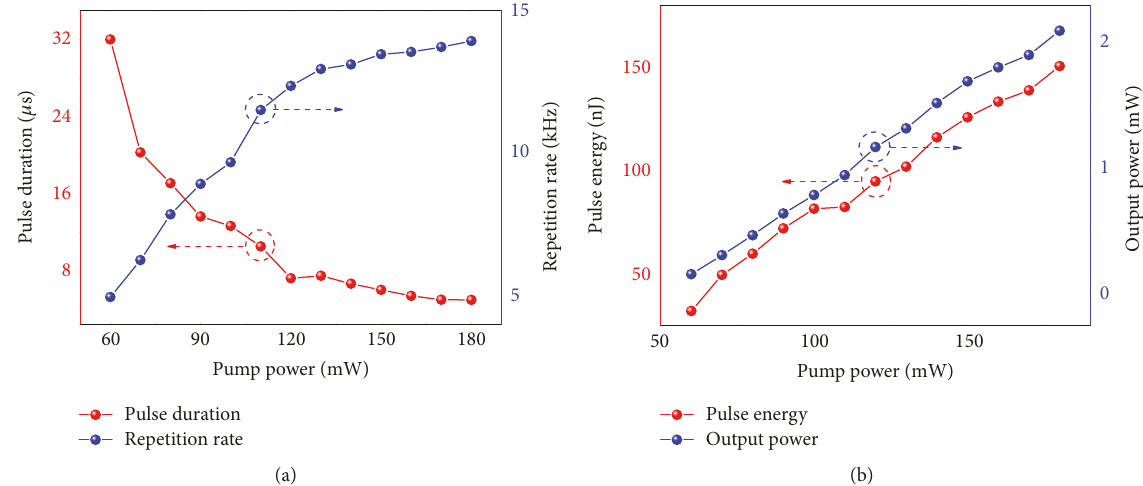
Figure 5: (a) The relationship between pulse duration and repetition rate with pump power. (b) The trend curves of output power and pulse energy with the pump